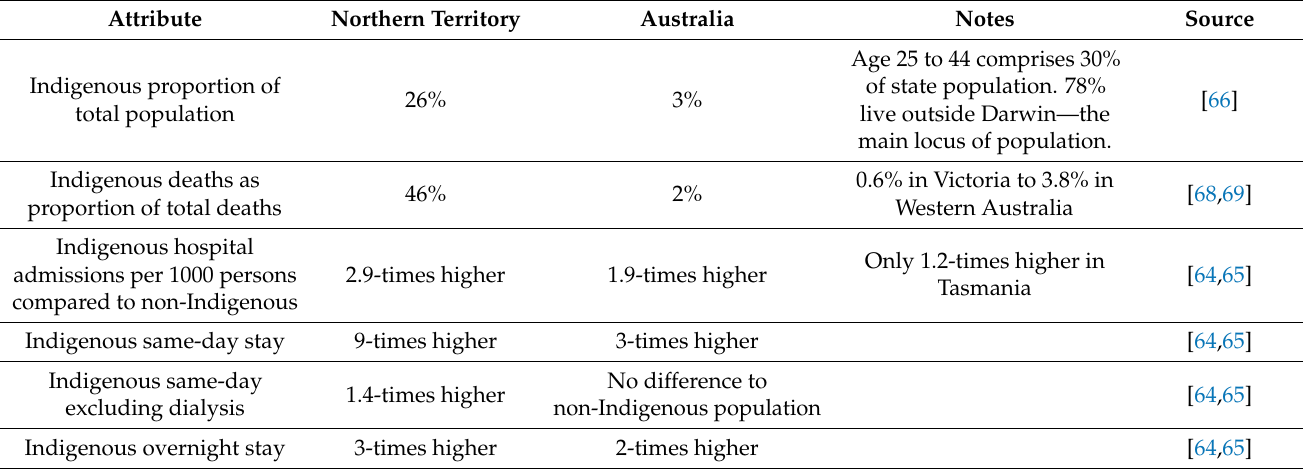
Table A1. Key features of indigenous population in the Northern Territory versus